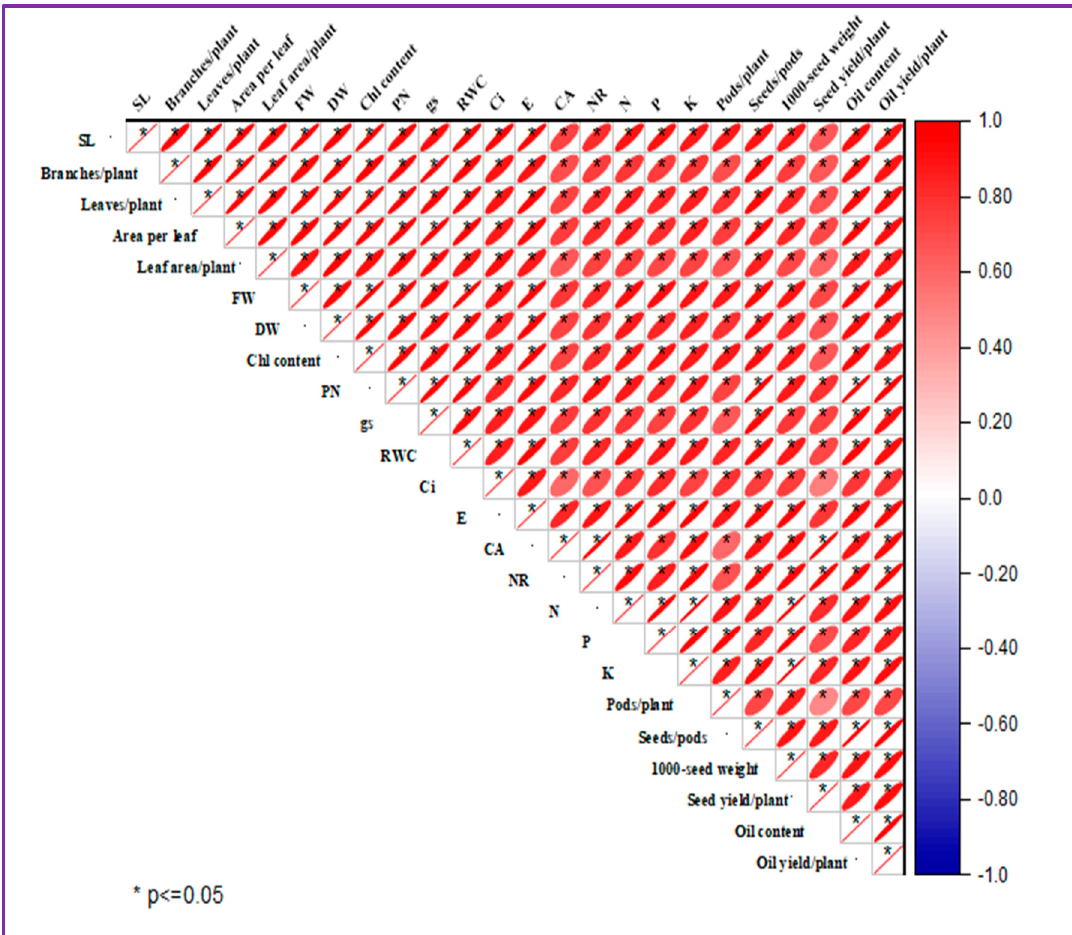
Figure 9. Pearson correlation matrix for the three cultivars and the various studied parameters. The symbol (*) represent significant level at p ≤ 0.05. The narrow ellipses showed greater correlation between the variables and the wider and more rounded ellipses represented that variables are un- correlated.